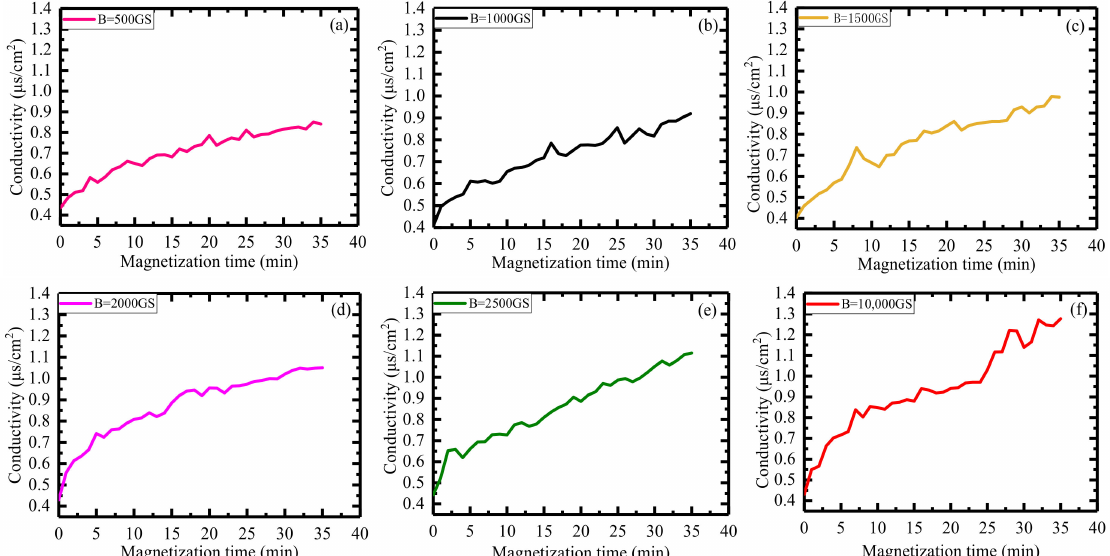
Figure 6. Change in conductivity of distilled water with magnetization time under different magnetic fields. Magnetic induction intensity: ( a ) 500 GS; ( b ) 1000 GS; ( c ) 1500 GS; ( d ) 2000 GS; ( e ) 2500 GS; ( f ) 10,000